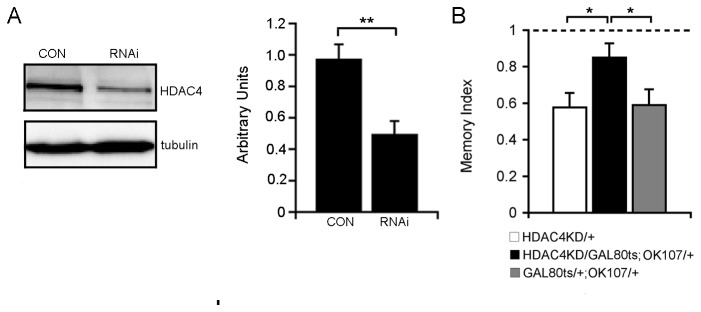
Knockdown of HDAC4 impairs LTM.HDAC4-RNAi expression was restricted to the adult brain with the TARGET system. A. Expression of HDAC4-RNAi in the fly brain repressed HDAC4 expression to ~50% of that of control brains. Western blot shows the expression of HDAC4::YFP in control (HDAC4::YFP/elavC155) and HDAC4 RNAi knockdown (HDAC4::YFP/elavC155; HDAC4RNAi/+) fly head lysates (labeled CON and RNAi, respectively). Blots were probed with anti-GFP to detect HDAC4::YFP and with anti-α-tubulin as a loading control. Image J was used to quantify band intensity (n=4 samples from 4 independent crosses, Student’s t-test, two-tailed, unpaired, **p<0.01). B. LTM was significantly impaired by OK107-GAL4 mediated knockdown of HDAC4 (HDAC4KD) (ANOVA, post-hoc Tukey’s HSD, *p<0.05).